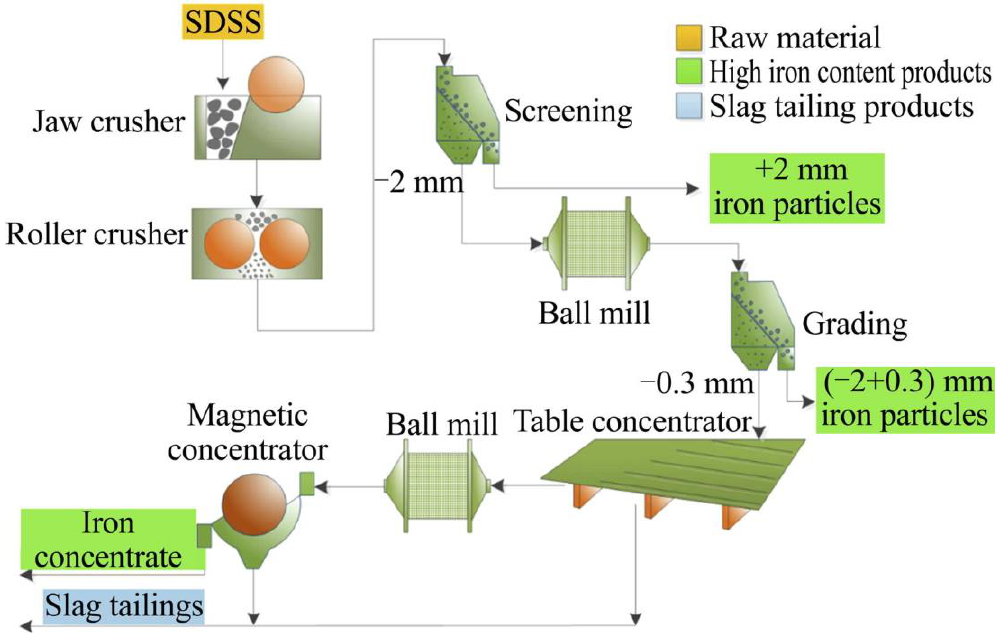
Figure 3. Flowsheet of SSDS beneficiation experiment. Source: [108]. CC-BY-NC-ND 4.0.